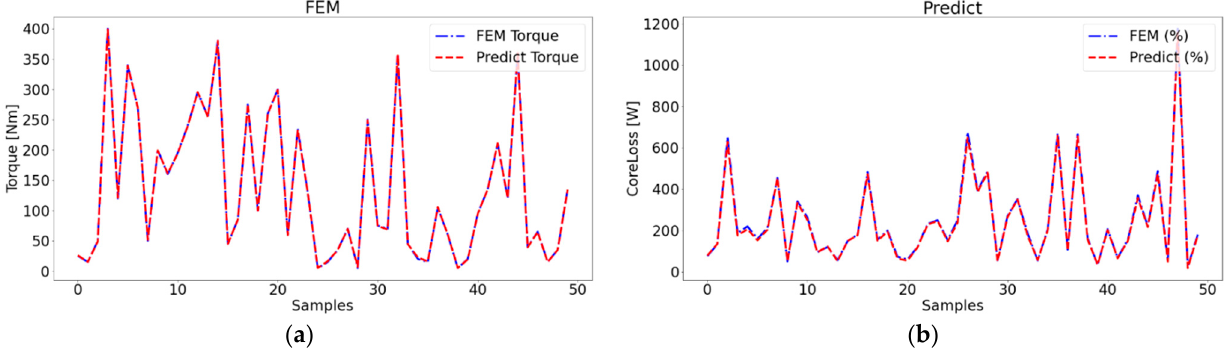
torque; ( b ) efficiency. Figure 11. Comparison between FEM and prediction for 50 samples obtained with Model ‐ 2: ( a )